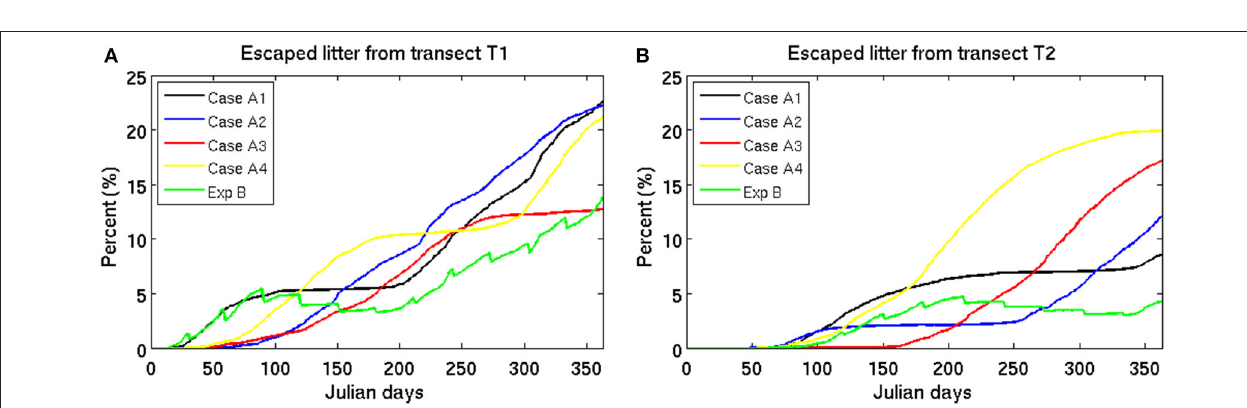
model predicted low litter concentration and beached particles in the eastern coastline of Aegean Sea (sub-region R3). Results for sub-region R3 (Topcu et al., 2010) refer to bigger floating